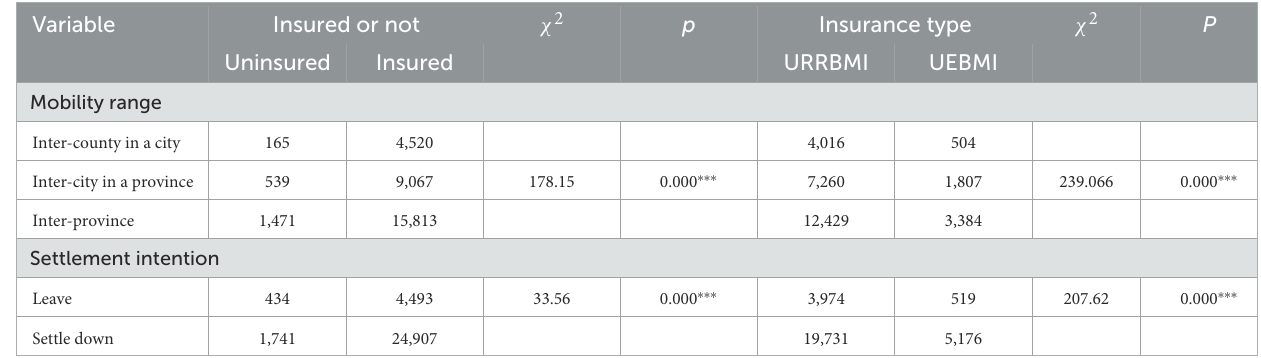
TABLE 2 Bivariate analysis